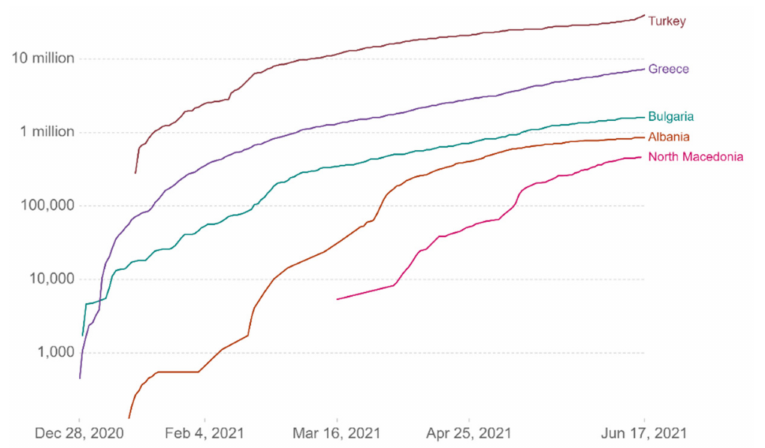
Figure 13. Vaccine doses